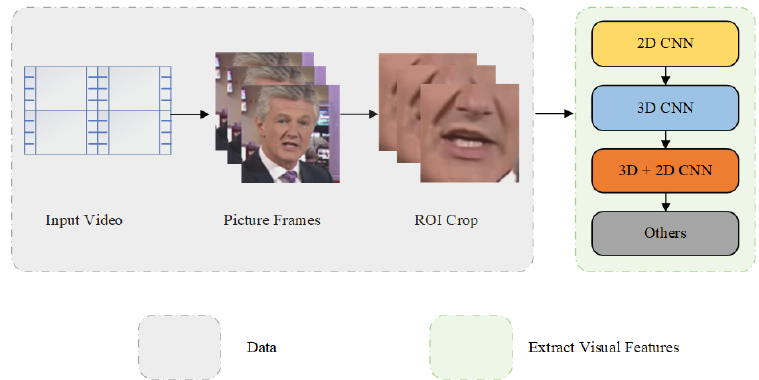
Figure 2. Visual feature extraction based on deep